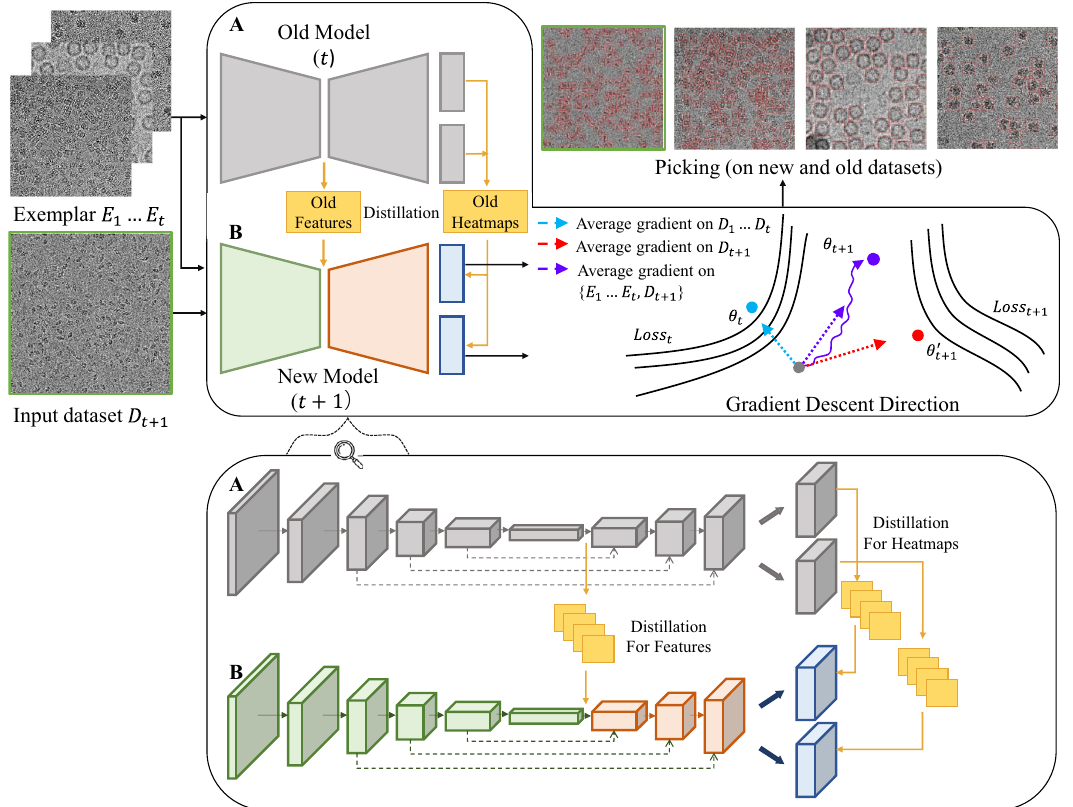
Fig. 1 Architecture of EPicker and schematic diagram of continual learning. The input data includes an exemplar dataset of datasets E 1 -- E t and a new dataset D t þ 1 (highlighted by green boxes). A and B represent branches A and B of the dual path network, respectively. Each branch is composed of a feature extraction sub-network (two trapezoids) and an object location sub-network (two rectangles). The gradient descent direction on the exemplar dataset θ t , the new dataset θ 0 t þ , and the combination of the two datasets θ t þ 1 is indicated by blue, red, and purple arrows, respectively. The bottom panel shows the 1 magni fi ed details of the network, in which branch B distills knowledge of features and heatmaps (yellow squares) from the corresponding network blocks (cuboid) of branch